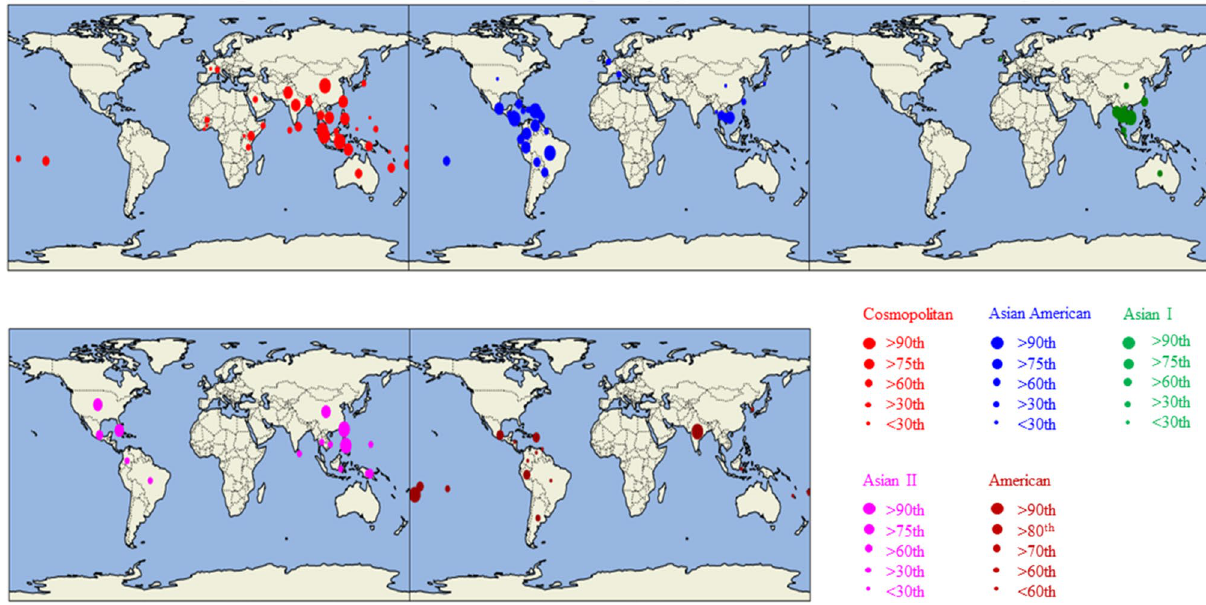
Figure 1. Spatial distribution of DENV-2 genotypes. Genotypes are represented by different colors as shown in the legend. The number of sequences belonging to each genotype reported by all countries was ranked into > 90th, 76–90th, 60–74th, 30–59th and < 30th percentile categories that are shown in circles of different size. Due to low sample size, the percentile ranking for American genotype was done at > 90th, > 89–80th, > 79–70th, > 69–60th and < 60th percentiles for better visualization. The data was plotted onto the global map by using a custom made python v3.6 script built on cartopy.mpl.gridliner map builder module that was run on Spyder 4.1.5 software integrated into the open source Anaconda Navigator (https:// docs. anaco nda. com/ anaco nda/ insta ll/ windo ws/). Based on the data available in NCBI database, the period of sampling for sequencing was from 1944 to